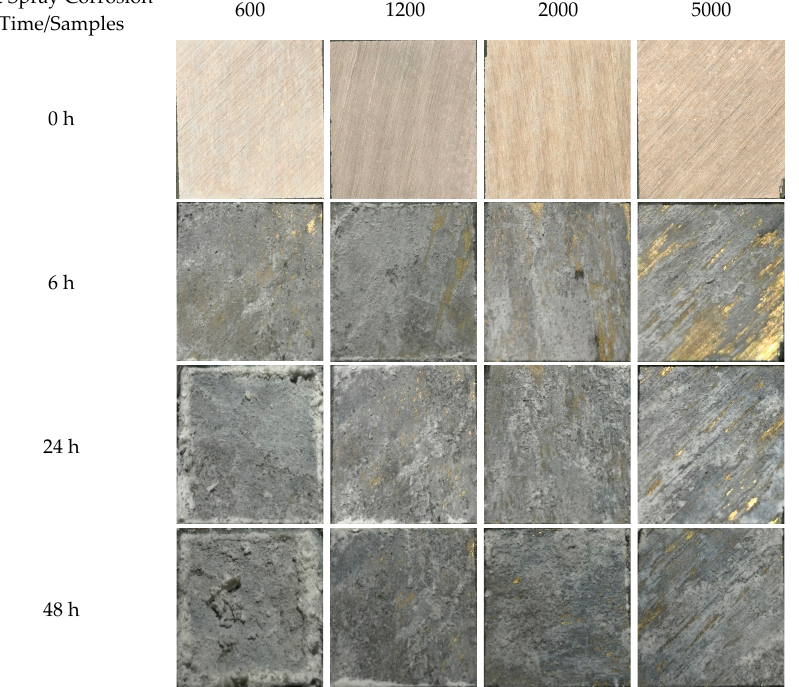
Figure 9. The surface state of the neutral salt spray test of the samples at 0, 6, 24, 48 h.